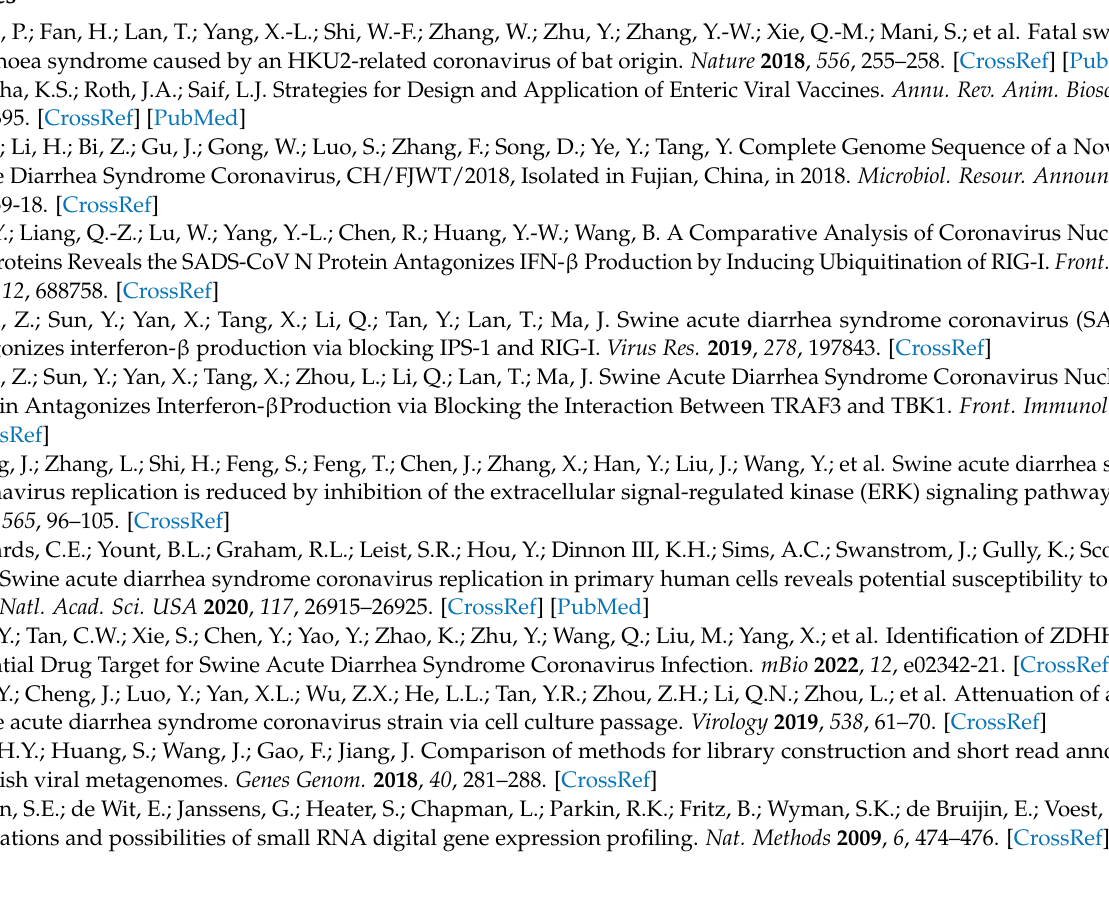
I − V set. Table S2: The miRNAs of P set and I − V set. Table S3: The cicrRNAs of P set and I − V set. Table S4: The lncRNAs of P set and I − V set. Table S5: The TUCPs of P set and I − V